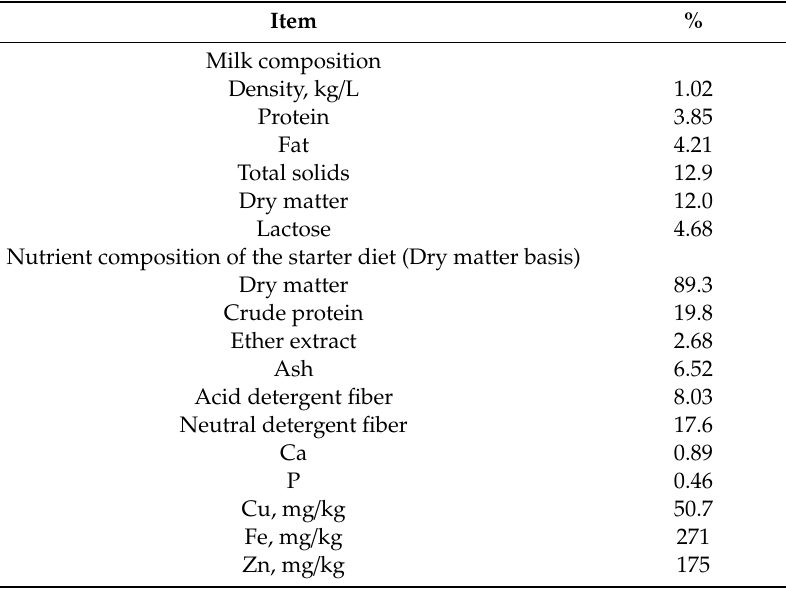
Table 1. Nutrient composition of the milk and starter diet (%, unless noted) 1